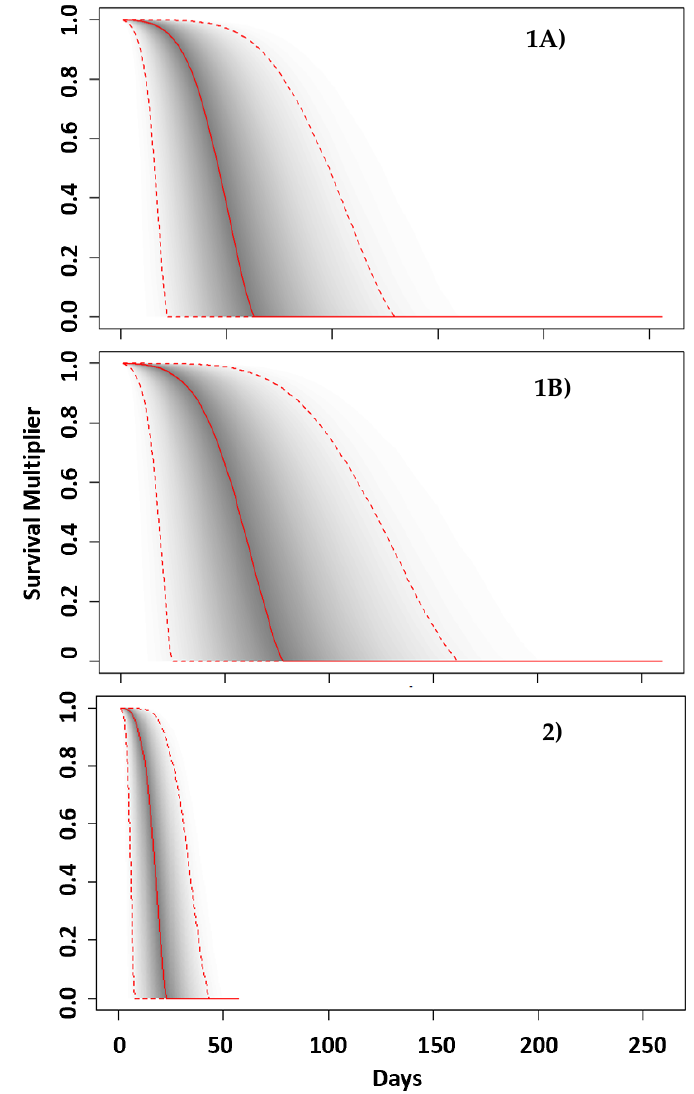
Figure 3. Dose–response functions for Scenarios 1A (extended low salinity event in “poor” environment, 1B (extended low salinity event in “good” environment) and 2 (acute salinity change). Figure shows the quantiles of the distribution generated by 10,000 realizations; the red solid line is the median and the dashed lines are the 5th and 95th quantiles (i.e., forming a 90% interval).